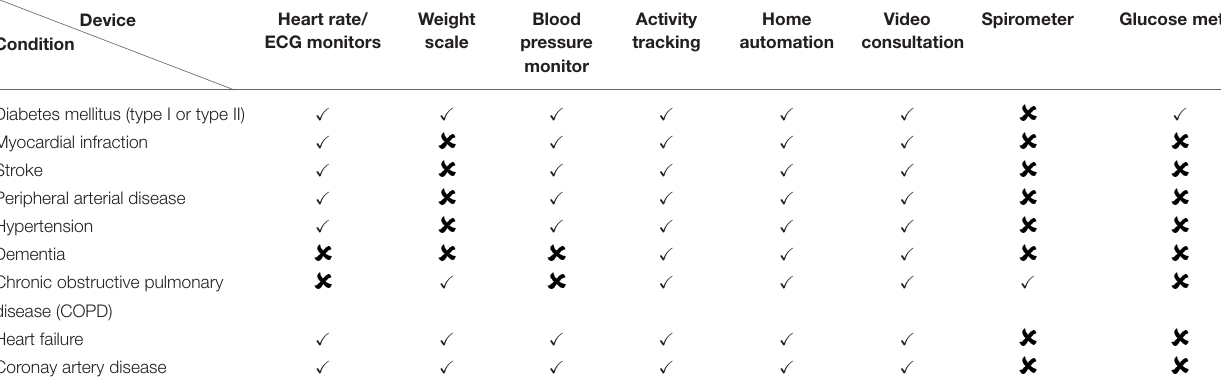
TABLE 1 | Devices per medical indication.